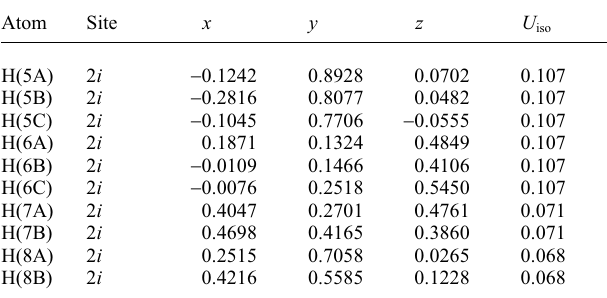
Table 1. Data collection and handling.